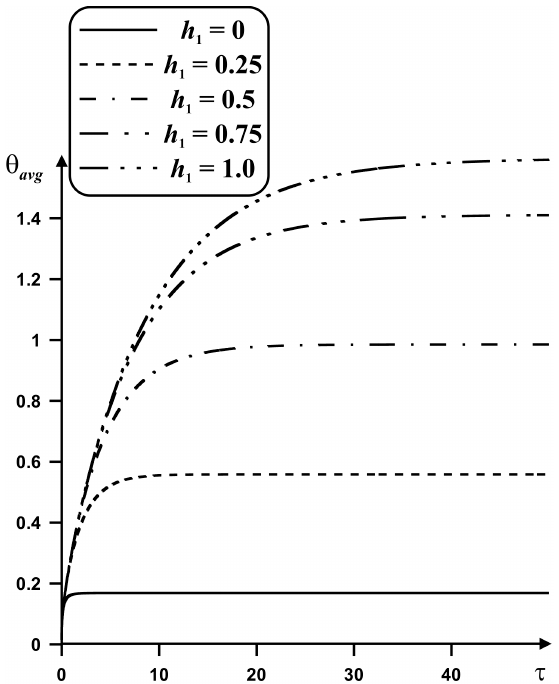
ζ = 0 and various values of h